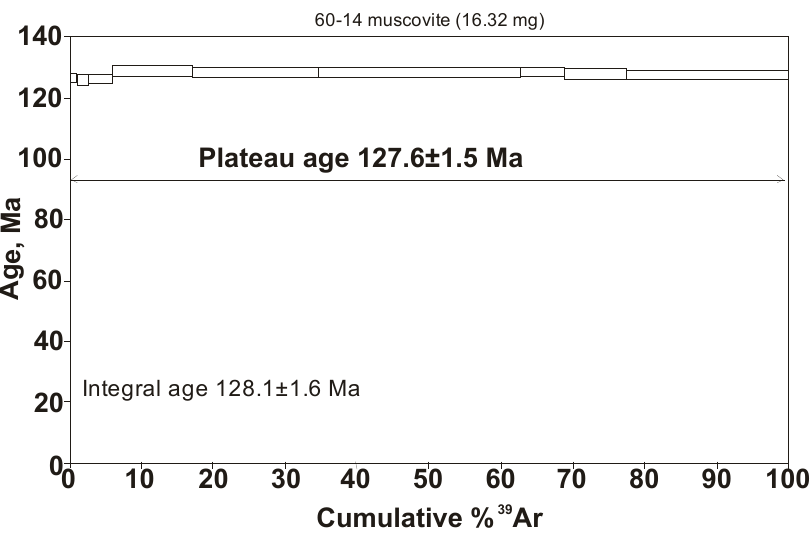
Figure 4. 40 Ar/ 39 Ar isotopic dating of muscovite from molybdenum ores of the Pervomaiskoe deposit. Re-Os dating of molybdenite from the Pervomaiskoe deposit indicated two values of isotopic age: 118.5 ± 1.6 and 122.4 ± 1 Ma (Table 2). Table 2. The isotopic age of molybdenite by 187 Re- 187 Os isotopic dating of molybdenite.